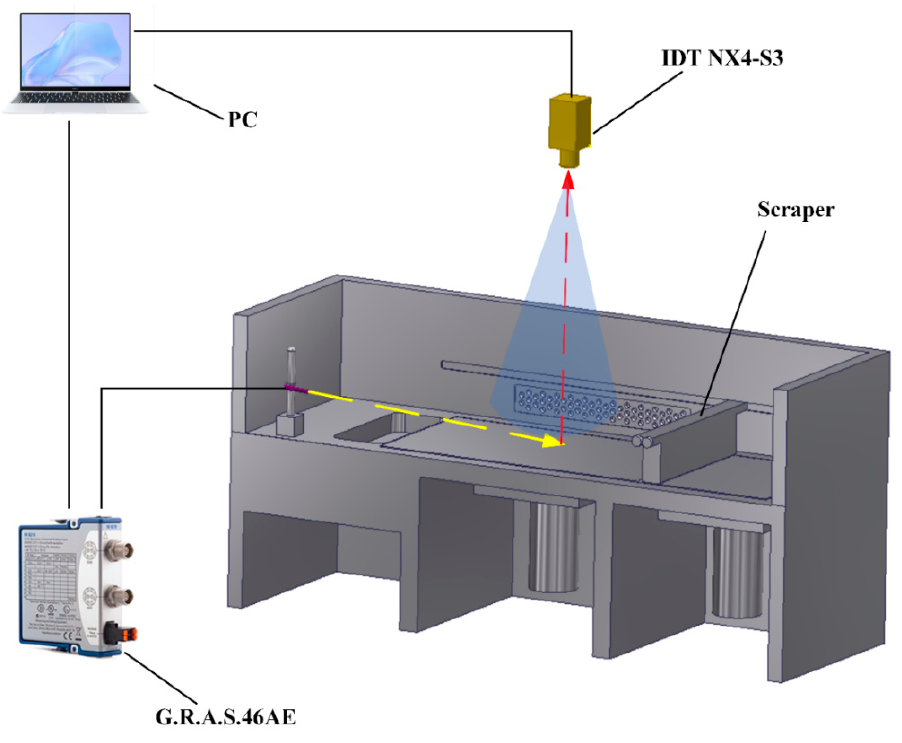
Figure 2. Schematic of microphone sensor and coaxial high speed camera monitoring system for the SLM process.